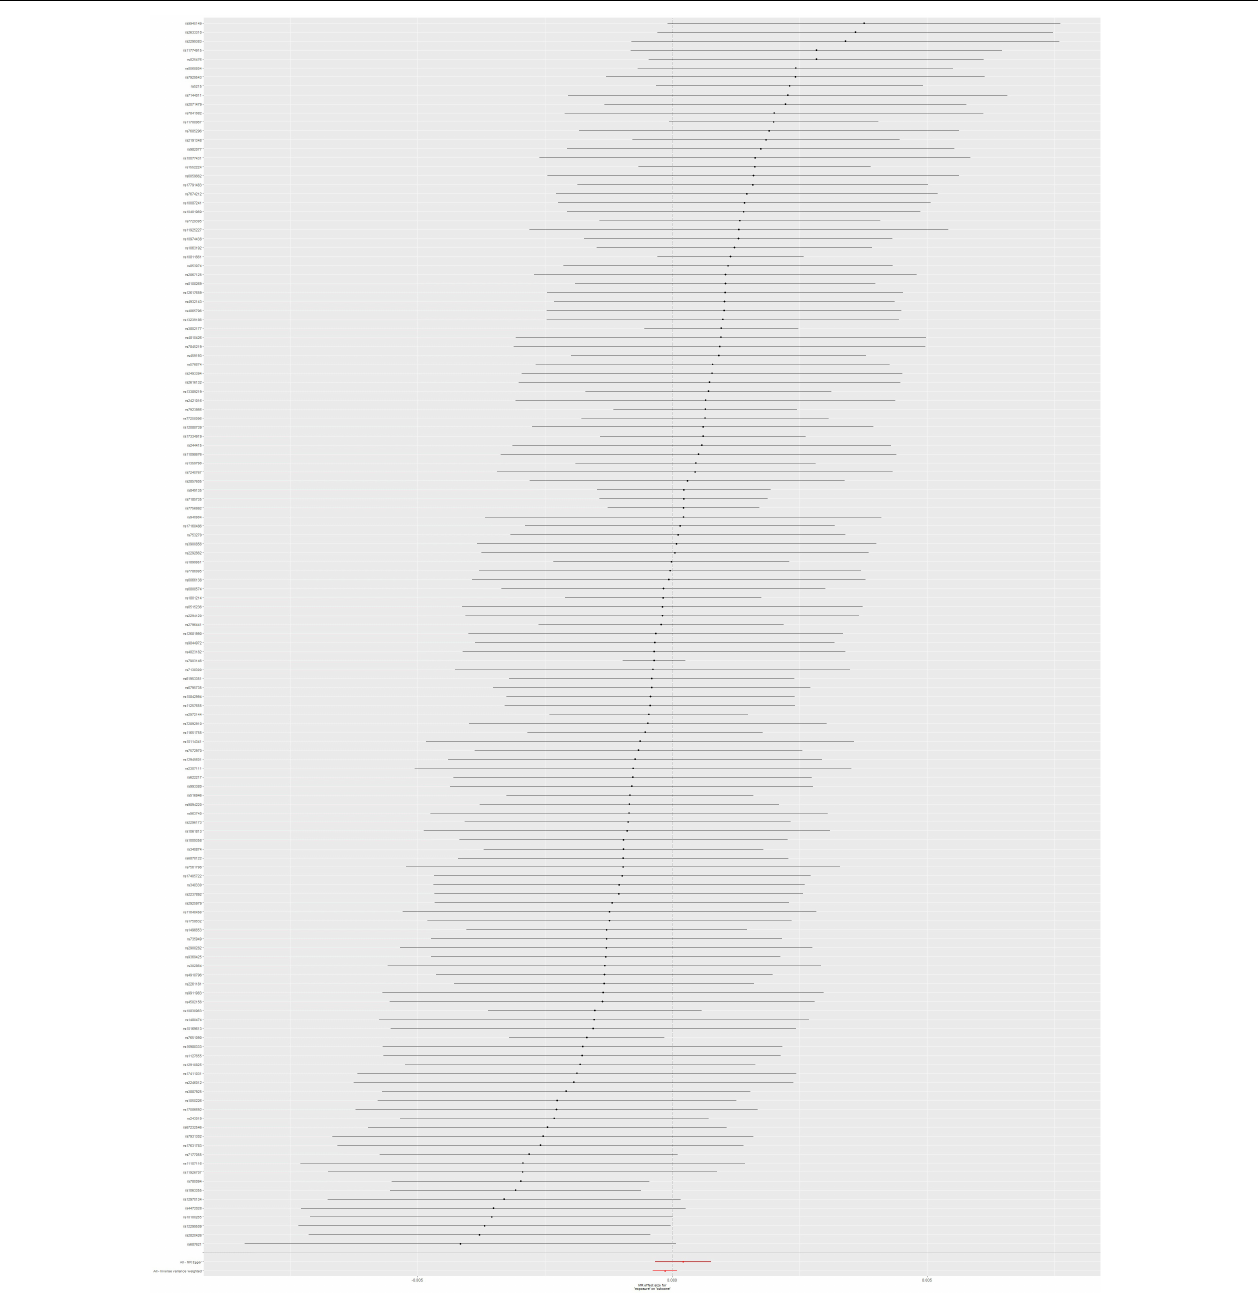
FIGURE 3 | Forest plot: the associations between T2DM-related SNPs and SSTI risk. T2DM, type 2 diabetes mellitus; SSTI, skin and soft tissue infections; SNPs, single-nucleotide polymorphisms; OR, odds ratio; CIs, confidence